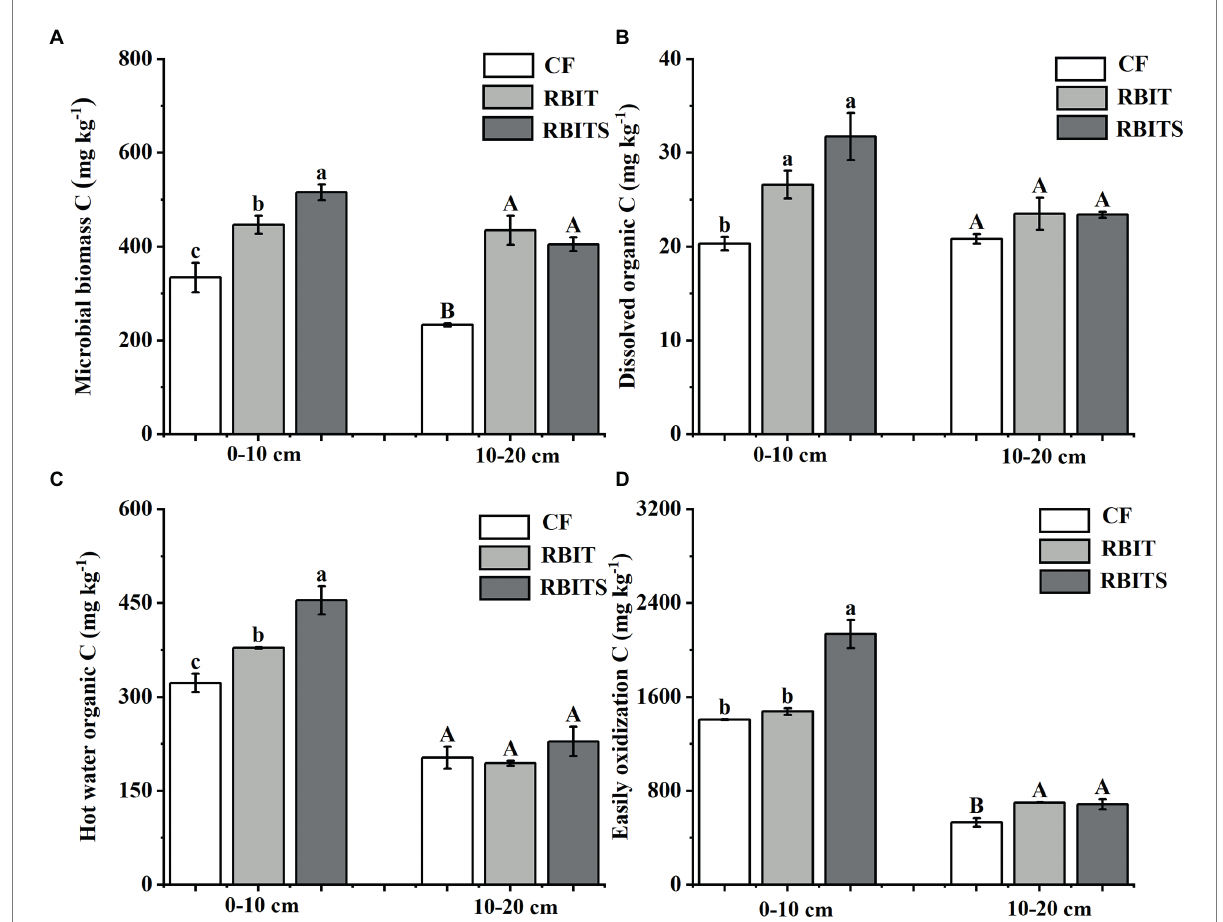
FIGURE 5 Effect of fertilization management on the content of microbial biomass C (A) , dissolved organic C (B) , hot water organic C (C) , and easily oxidizable C (D) at depths of 0–10 cm and 10–20 cm after nine years. CF : conventional fertilization; RBIT: reduced basal and increased topdressing fertilizer rate; RBITS: RBIT combined with straw incorporation. MBC: microbial biomass carbon; DOC: dissolved organic C; HWOC: hot water organic C; EOC: easily oxidizable C. The different lowercase and uppercase letters represent significant differences ( p ≤ 0.05) among treatments at depths of 0–10 cm and 10–20 cm, respectively. Error bars are standard error (SE) of the